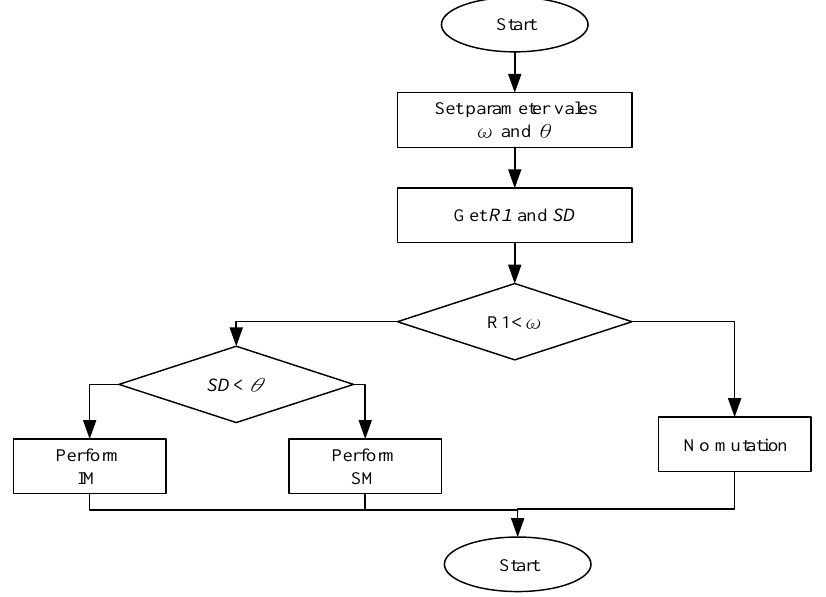
Figure 10. The workflow of Algorithm A2 of the procedure mutation ( ).